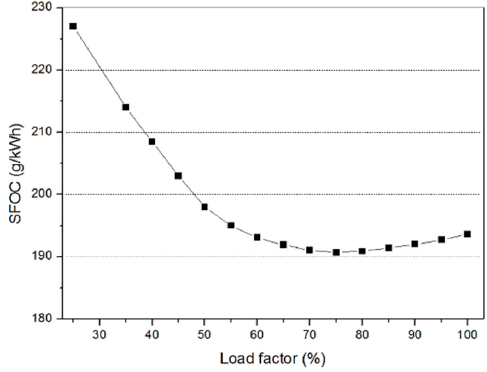
Figure 10. Example of a genset fuel consumption graph [35].